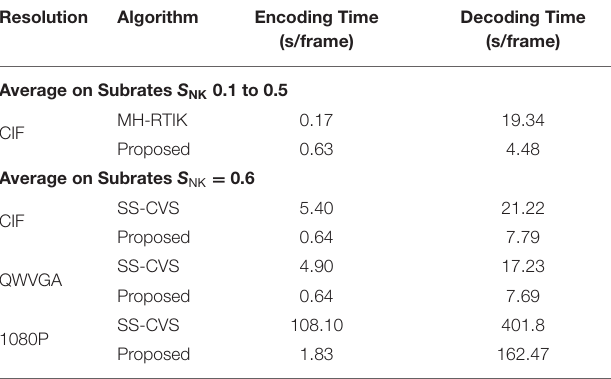
TABLE 2 | Average encoding time (s/frame) and decoding time (s/frame) on video sequences with different resolutions for the proposed CVS system, SS-CVS (Li et al., 2020), and MH-RTIK (Chen C. et al.,